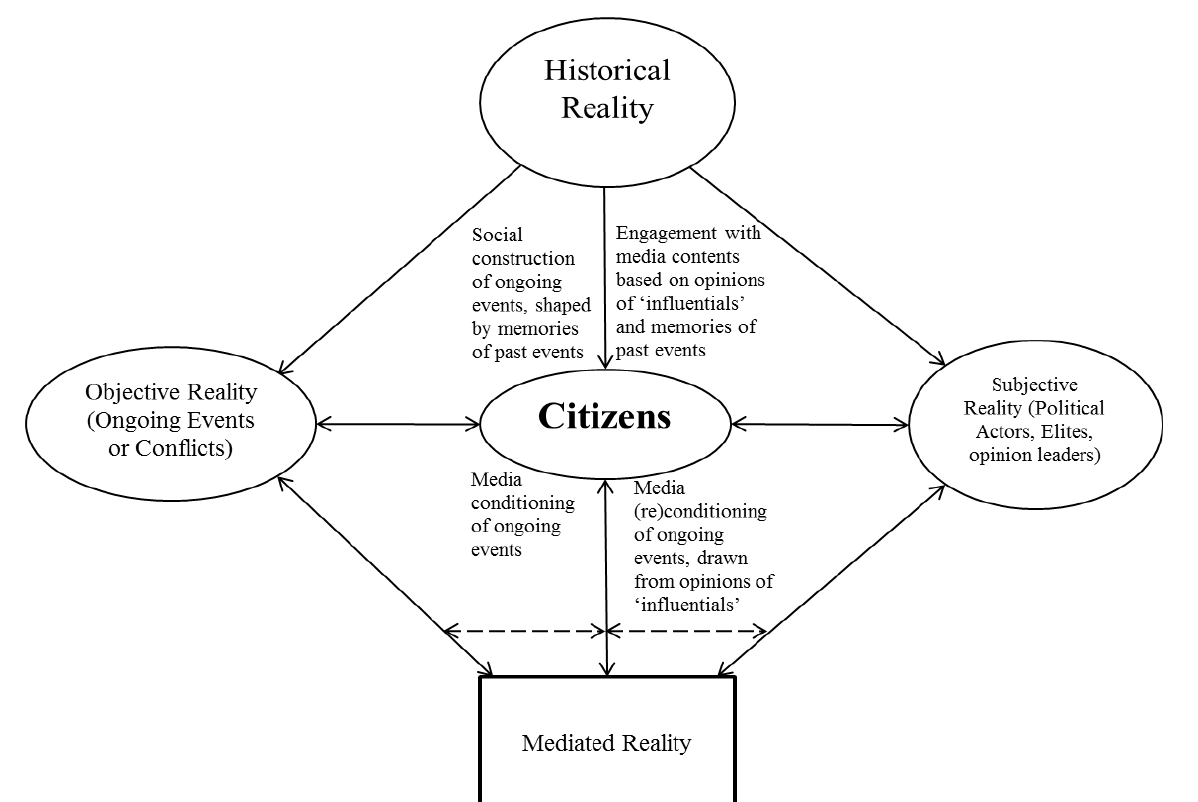
Figure 3 . Contending realities in conflict